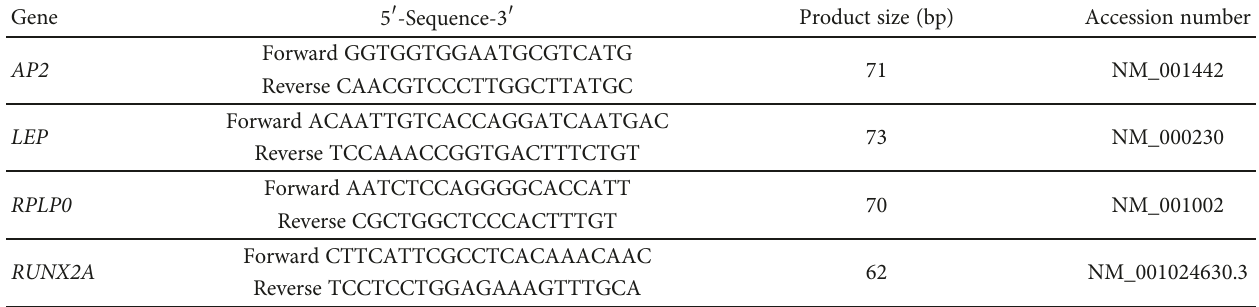
Table 2: The primer sequences and accession numbers for qRT-PCR.